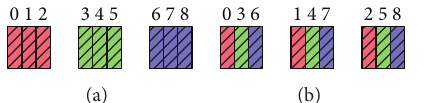
Figure 6: The above 2 sets of memory banks illustrate a simple addressing scheme and an interleaving addressing scheme. Certainly more complex addressing/hashing exists but is beyond the scope of this paper.